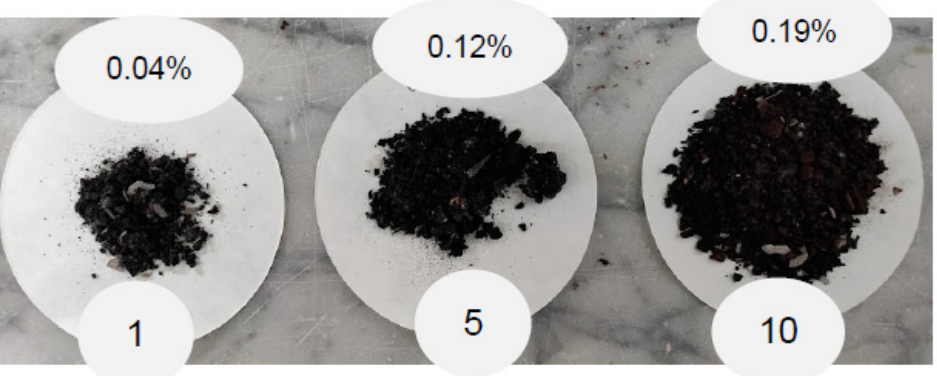
Figure 11. Loss of asphalt concrete samples material in the thaw waters after 1, 5 and 10 F–T cycles.